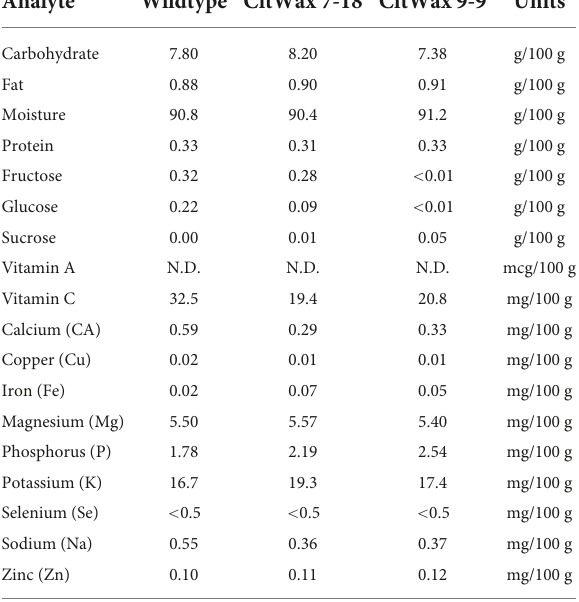
TABLE 3 Nutrient compositional analysis of CitWax lines 7-18 and 9-9 compared to store bought wildtype Mexican lime juice. Analyte Wildtype CitWax 7-18 CitWax